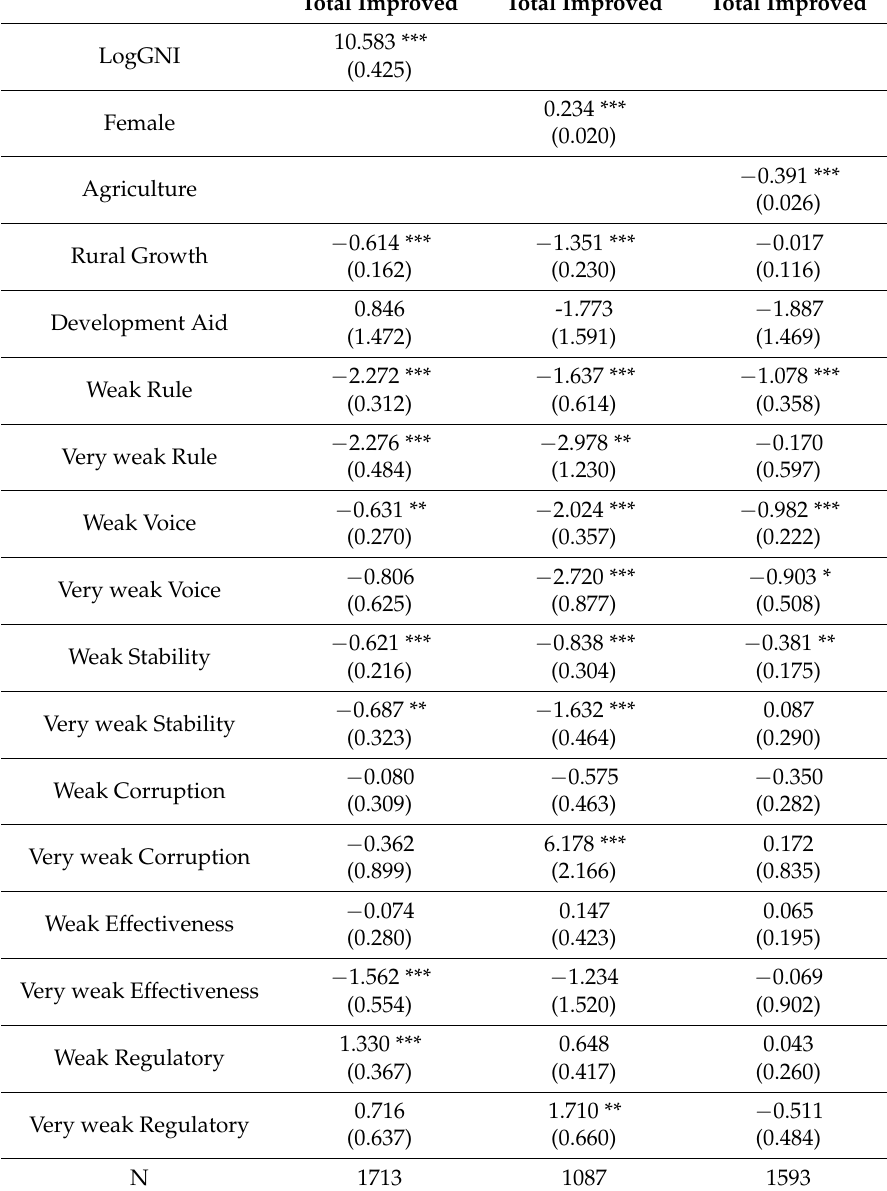
Table 2. Socioeconomic indicators. Global data. Total improved